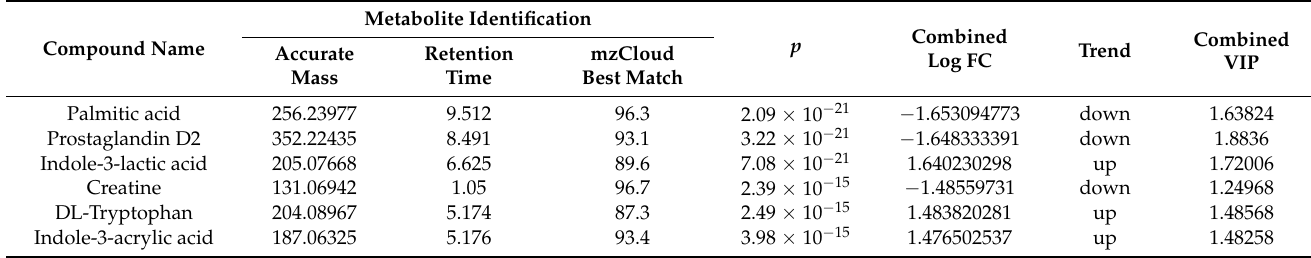
Table 3. Differential metabolites for estazolam fatal intoxication in brainstem tissue